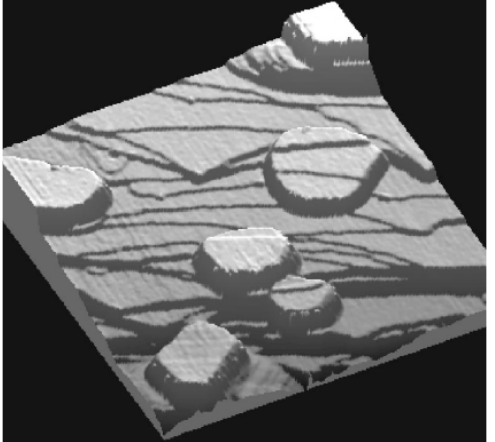
Figure 2. STM image (size: 300 × 300 nm 2 ; bias: 1.2 V) showing several Pb islands on a stepped Cu(111) surface. The top surface of the Pb crystallites is atomically flat, but steps on the substrate can still be recognized at the surface of the islands due to lattice-mismatch of Pb and Cu. From [21] (Copyright American Physical Society